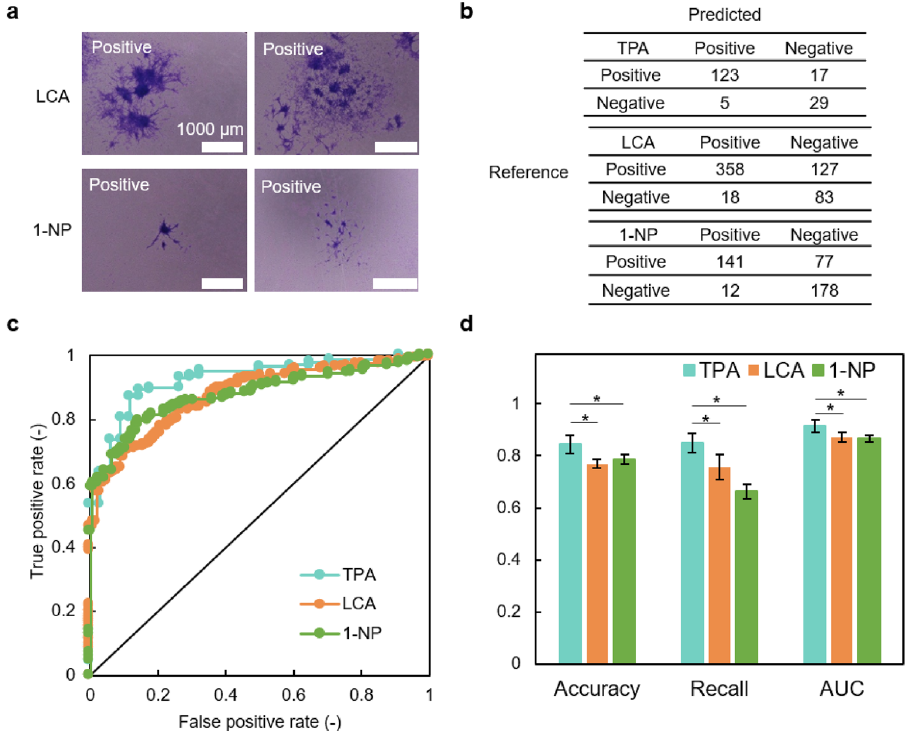
Figure 5. Application of CNN algorithm to other promoters. ( a ) Representative images of transformed foci induced by exposure to LCA and 1-NP. ( b ) Confusion matrix. The Confusion matrix when the AUC value is the median value out of 5 trials is posted. ( c ) ROC curves. The ROC curve of the trial when the AUC value became the median value out of 5 trials is posted. ( d ) Comparisons of CNN performance for three chemicals. The values indicate the mean and deviation of 5 trials. Statistical significant difference was assessed by one-way analysis of variance and Dunnett’s t test. * P < 0.01 was considered significant.